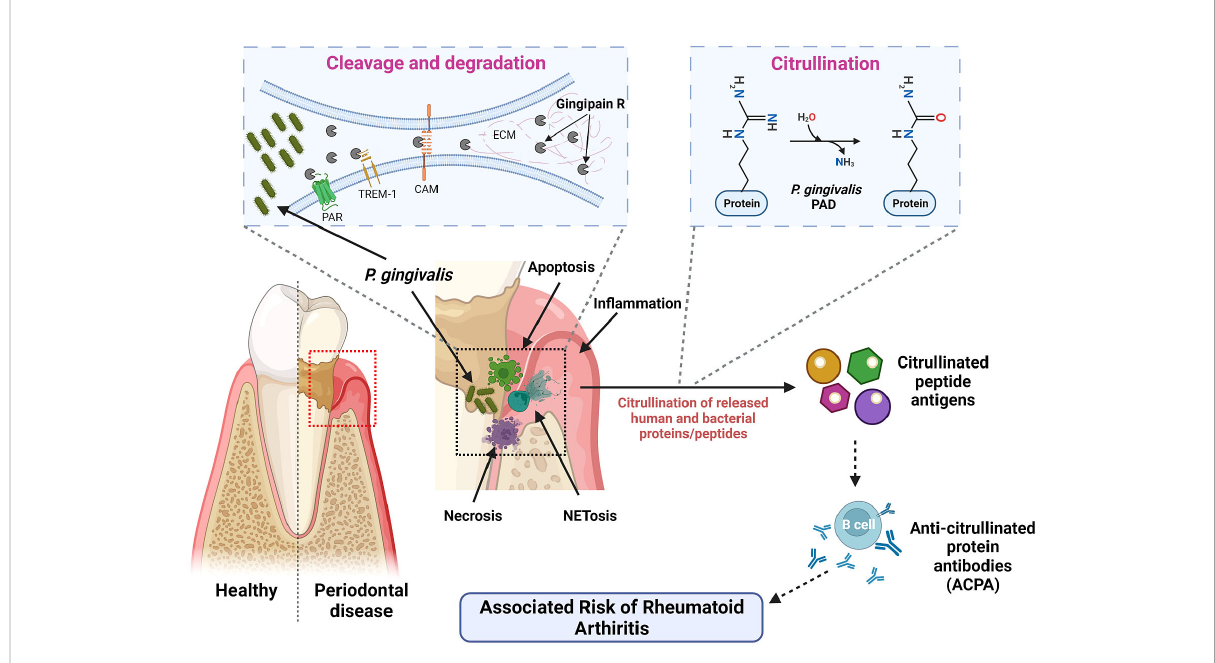
FIGURE 2 Mechanism of action of P. gingivalis virulence factors – Rgp and PPAD. P. gingivalis invades by secreting gingipains, which shred and degrade different cell receptors and ECM components. This disrupts signaling pathways and promotes tissue damage. PPAD and human PAD then citrullinate the liberated peptides. These citrullinated peptide antigens are recognized by antigen-presenting cells, resulting in the generation of anti-citrullinated protein antibodies (ACPAs) by the B cells. These ACPAs are associated with an increased risk of